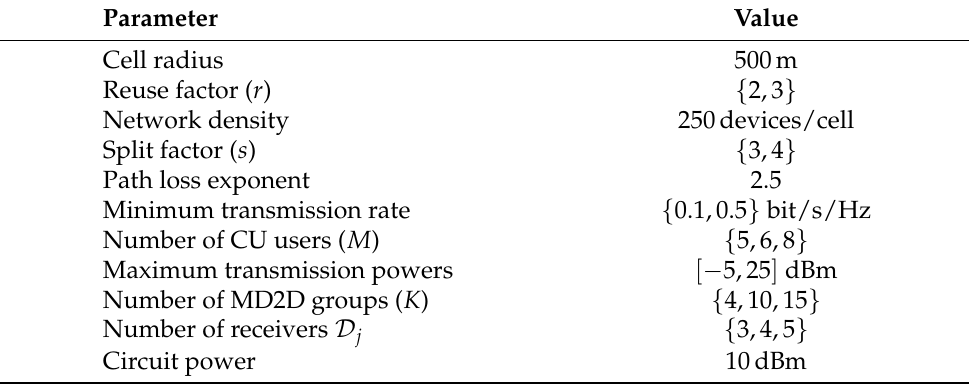
Table 2. Simulation parameters.